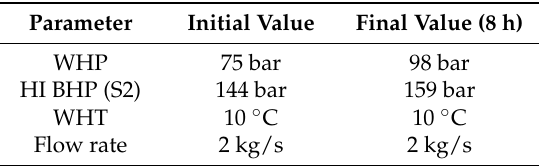
Table 2. The operating parameters for the eight-hour CO 2 injection in the flow rate control mode (2 kg/s).